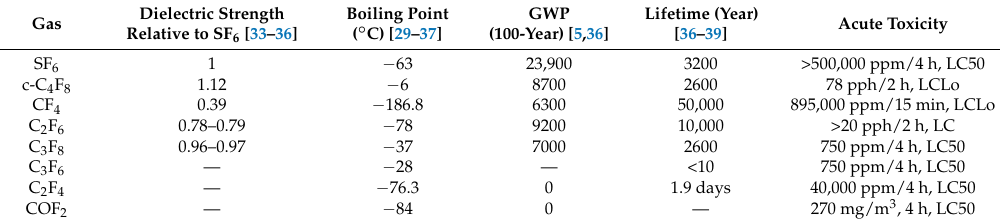
Table 6. Parameters of decomposition products.